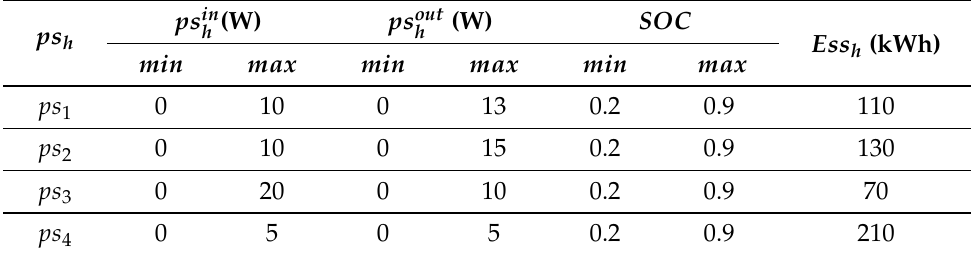
Table 4. List of power storage devices with power limitation.